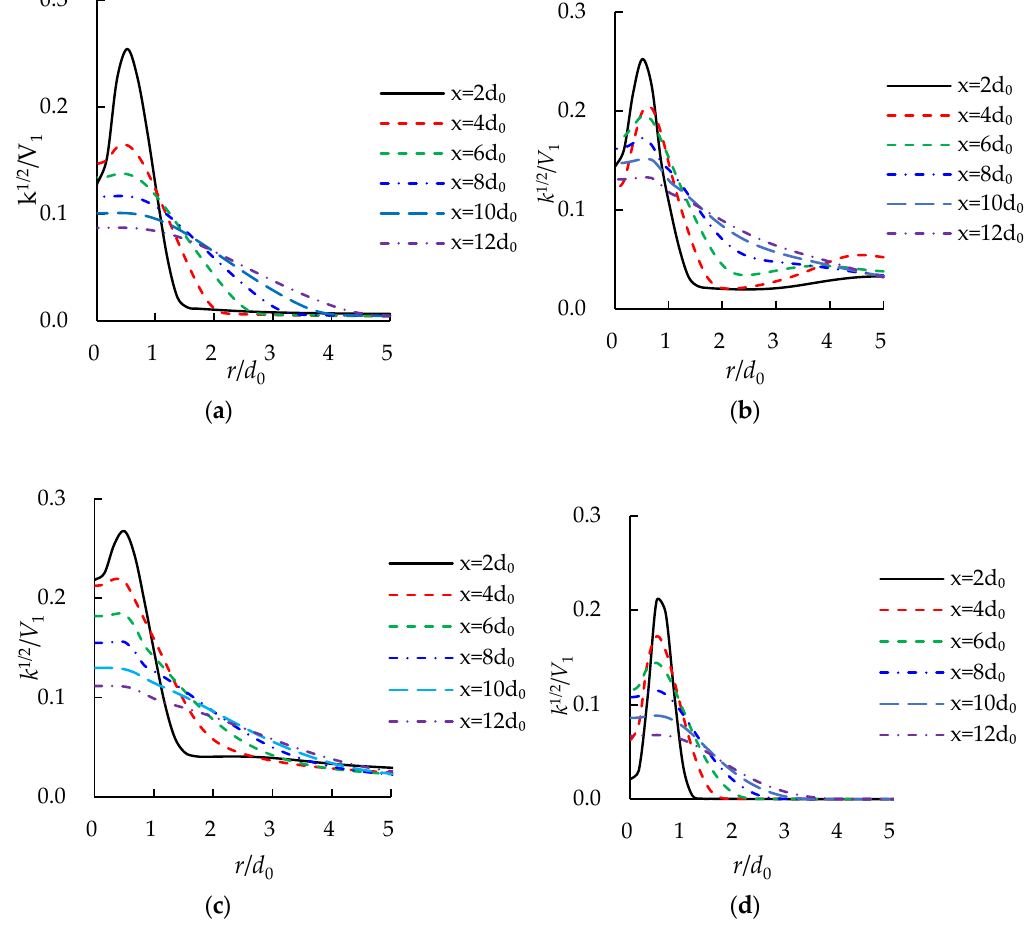
Figure 13. The k 1/2 / V 1 relationship with r/d 0 at different submerged depth sections for ( a ) a plunging jet at V 0 = 2 m/s, L 1 = 0.025 m ( V 1 = 2.12 m/s), ( b ) a plunging jet at V 0 = 2.5 m/s, L 1 = 0.025m ( V 1 = 2.60 m/s), ( c ) a plunging jet at V 0 = 2 m/s, L 1 = 0.179 m ( V 1 = 2.74 m/s), and ( d ) a submerged jet at V 0 = 2.12 m/s, L 1 = 0 m( V 1 = 2.12 m/s).